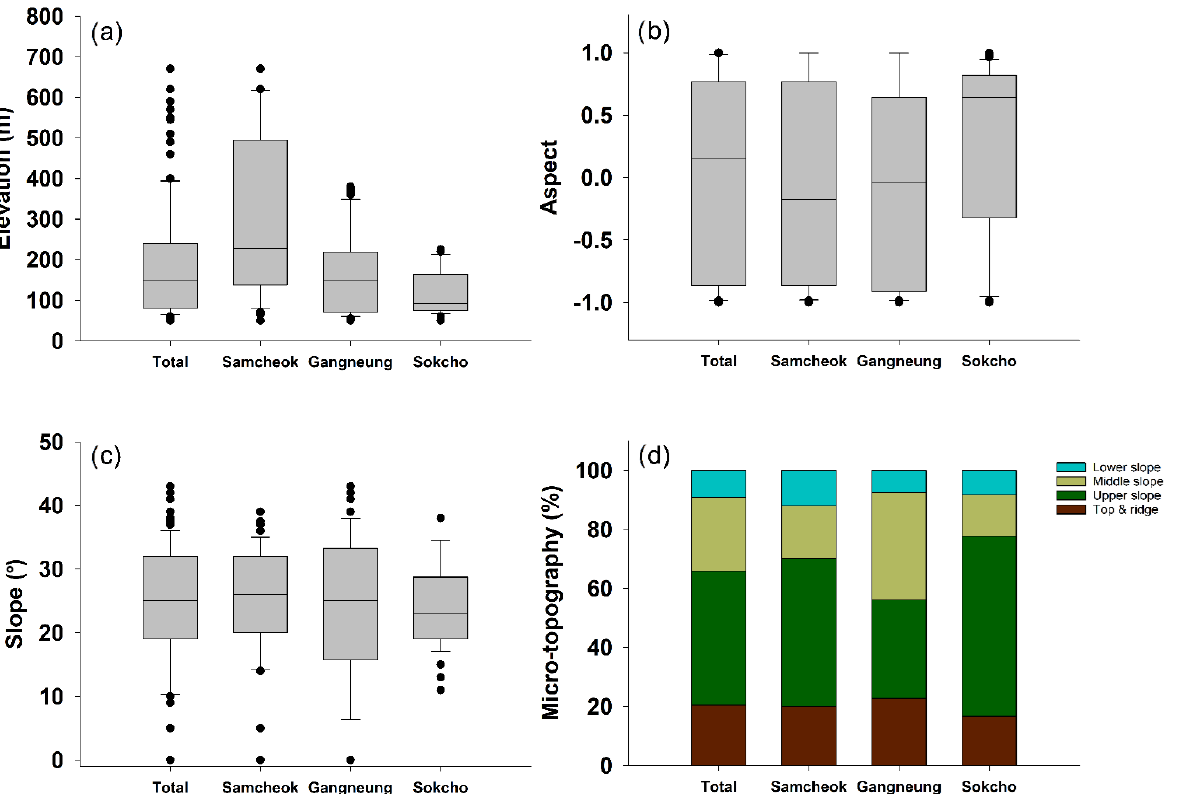
Figure 4. Four variables of the site factor: ( a ) elevation, ( b ) cosine-transformed aspect, ( c ) slope, ( d ) micro-topography. Fifty, 66, and 36 plots were investigated in Samcheok, Gangneung, and Sokcho, respectively, resulting in a total of 152.